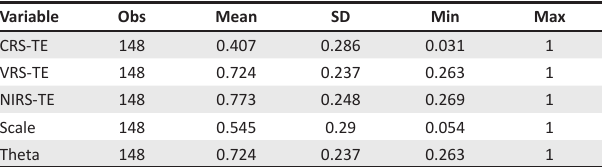
TABLE 3: Descriptive